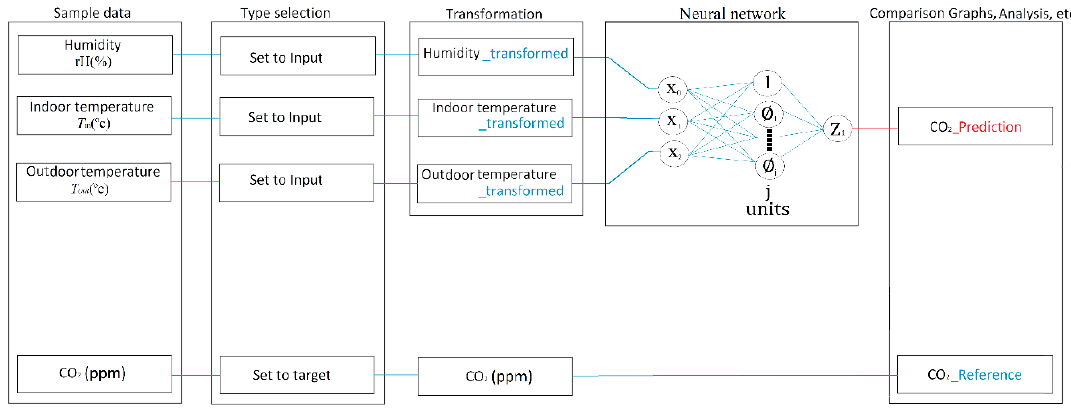
Figure 10. The block diagram of the developed Stream using IBM SPSS Modeler.